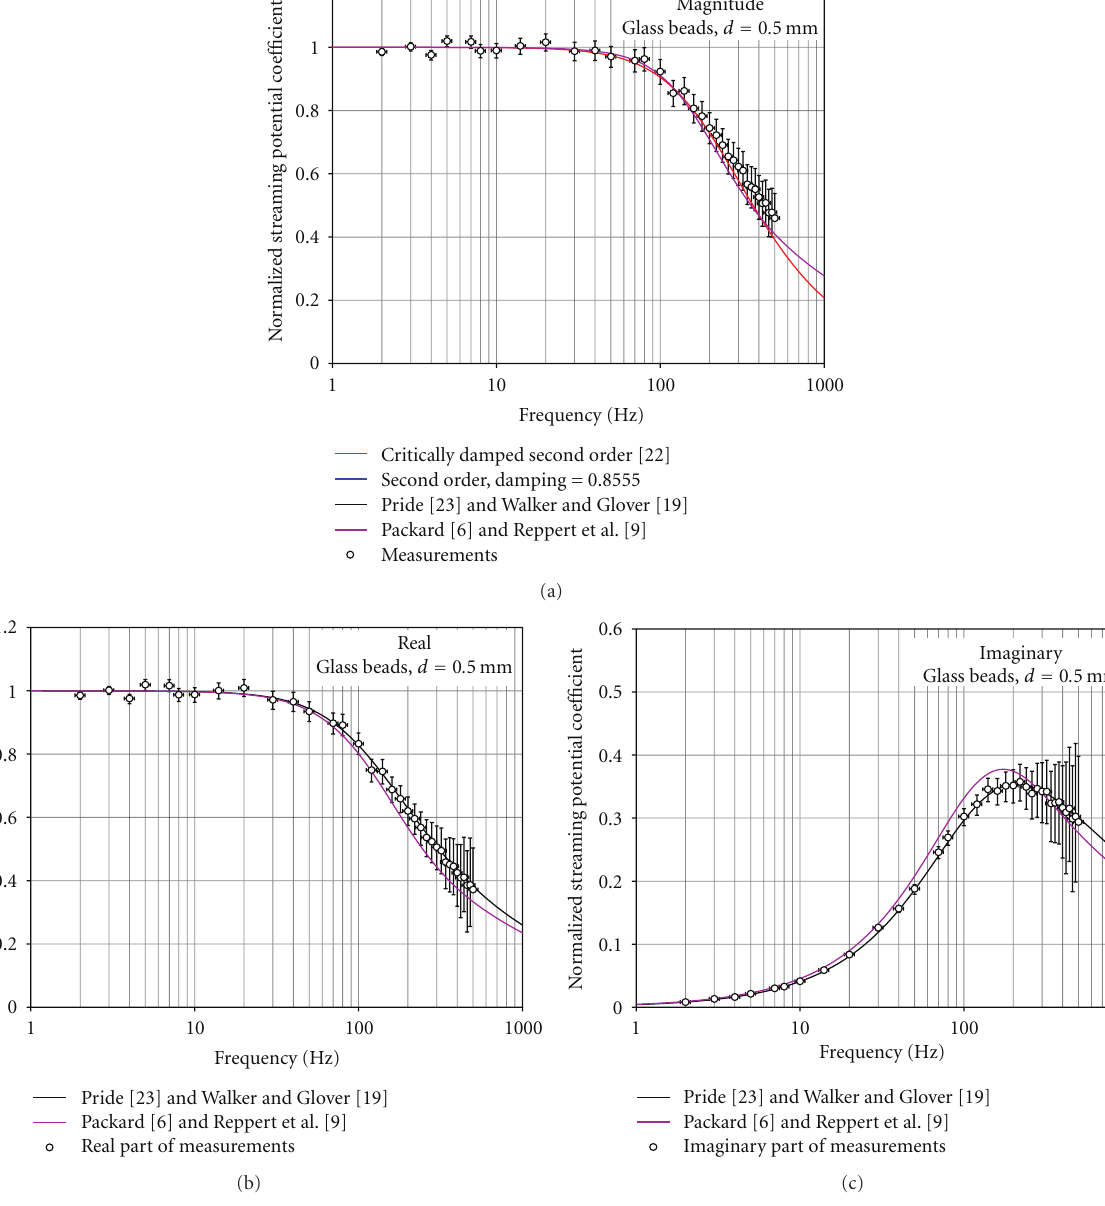
Figure 4: The calculated streaming potential coupling coe ffi cient (normalised to the value at 2Hz, which was 1.37 V/MPa) as a function of frequency for a pack of nominally 0.5mm diameter glass beads saturated with 10 − 3 mol/L NaCl solution at 24 ◦ C ( φ = 0 . 383, κ DC = 1 . 62 × 10 − 10 m 2 ). (a) Magnitude with six models shown fitting the data [6, 9, 19, 22, 23], (b) real component for models [6, 9, 19, 23], and (c) imaginary component for models [6, 9, 19,